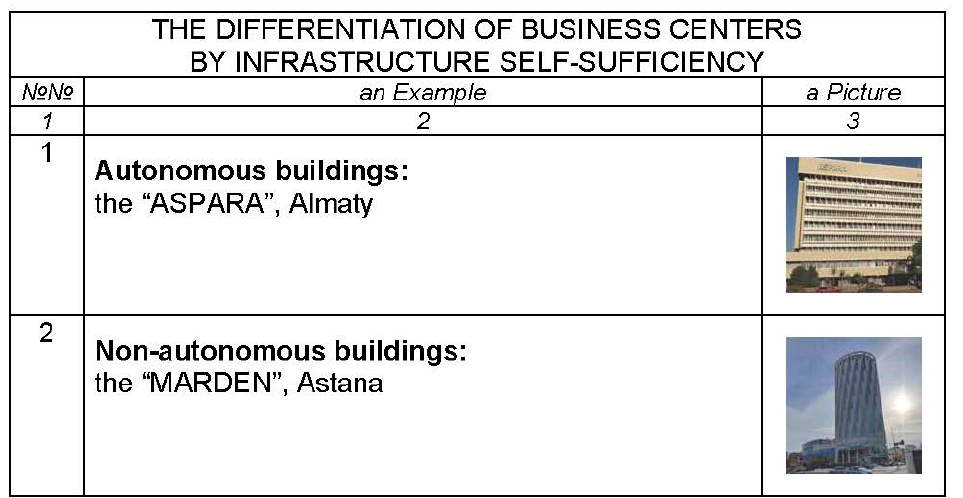
Figure 14. The differentiation of business centers by infrastructure self-sufficiency: ( 1 ) the ASPARA, Almaty [126]; and ( 2 ) the MARDEN, Astana [127].